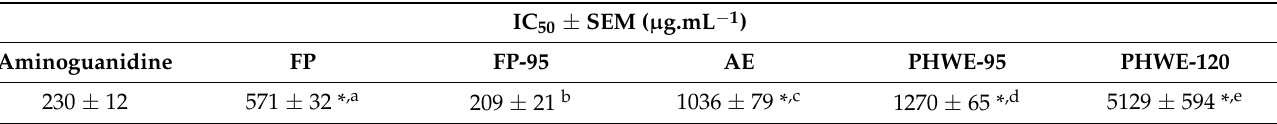
Table 4. IC 50 of AGE inhibition by polyphenols extracts (FP and FP-95) and polysaccharide–polyphenols conjugates (AE, PHWE-95, PHWE-120). Results are presented as the mean ± standard error of the mean (SEM) ( n = 9). Values with the symbol (*) are different from the positive control ( p < 0.05). Columns with different letter are significantly different ( p <